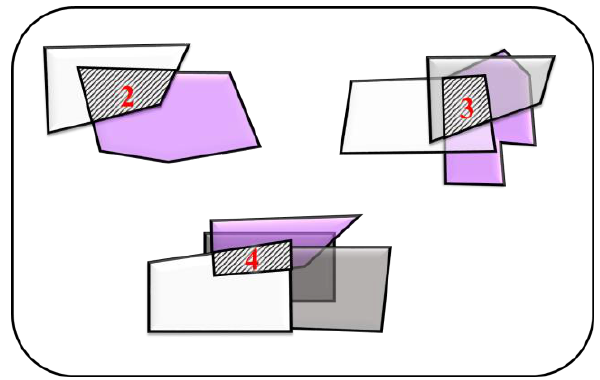
Figure 2. The frequency of polygons.